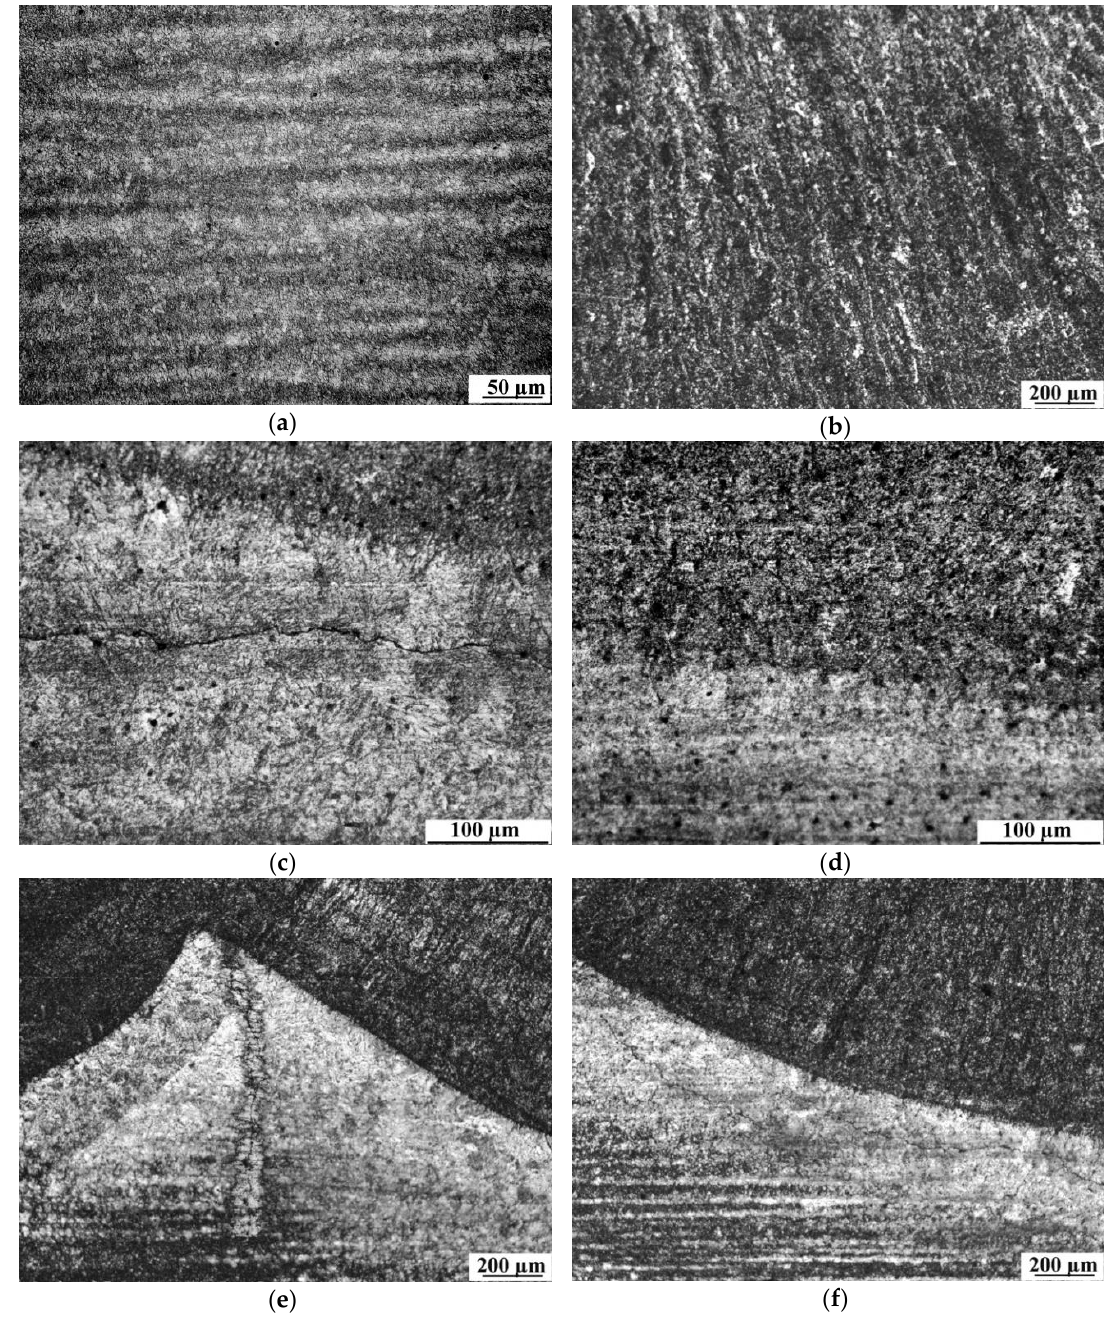
Figure 6 . Results of microscopic testing: ( a ) base material, ( b ) weld, ( c ) heat-affected zone (HAZ) in S1, ( d ) HAZ of weld number 1 (area C) in S2, ( e ) overlapping of two HAZs (area H) in S2, ( f ) HAZ of weld 3 (area A) in S2. Etch: 4% Nital. Table 5. The length of cracks in specimens S1 and S2.